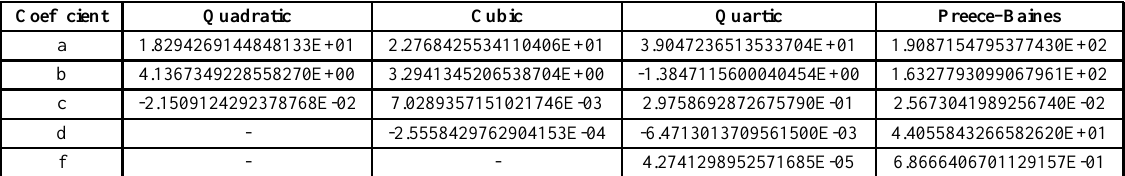
Table 8. Beacons-only functions’ coefficients.